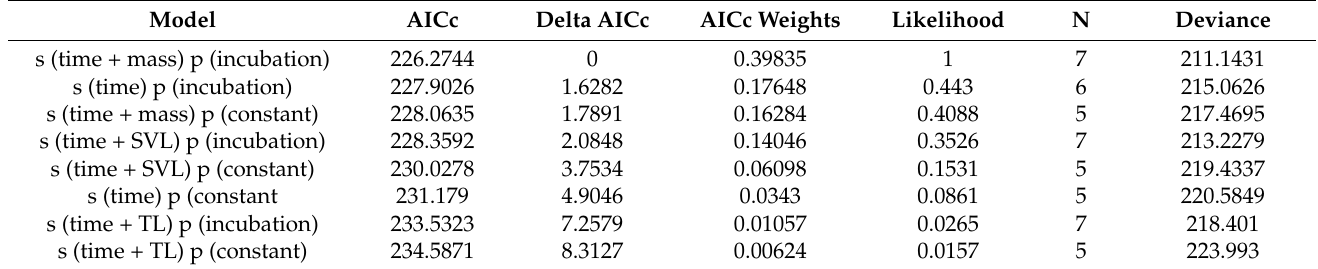
Table 3. Results of survival analyses used to compare rates of apparent survival (s) and recapture (p) for warm-incubated and cold-incubated hatchling geckos that were captured at Nowra in 2016. The candidate models were ranked based on their AICc values and associated AICc weights; models with delta AICc < 2.0 have the greatest statistical support. The table also shows the model likelihood, number of parameters (N), and model deviance. Incubation refers to incubation treatment (warm vs. cold); SVL and TL indicate the covariates snout-vent length and tail length,